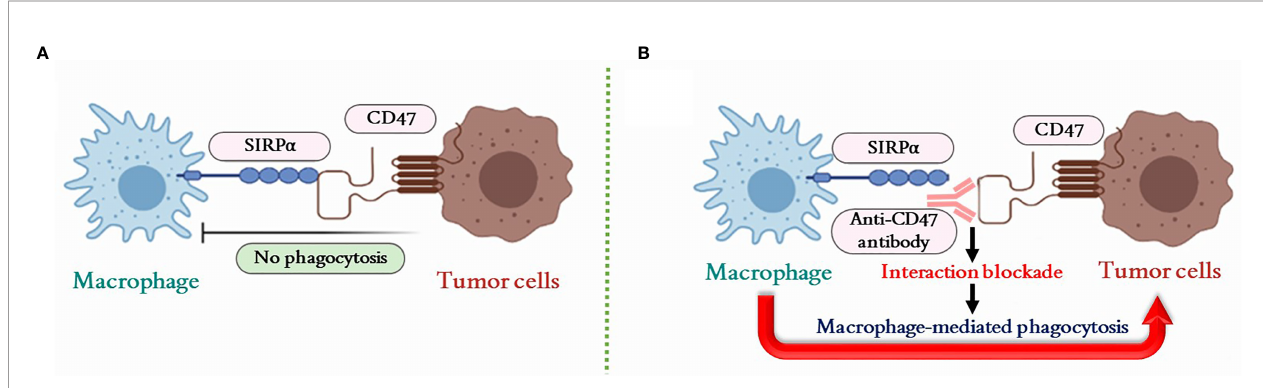
FIGURE 1 | Macrophage-mediated phagocytosis regulated by the CD47 – SIRP a pathway. (A) The CD47 – SIRP a interaction inhibits macrophage-mediated phagocytosis on tumor cells. (B) The interaction of CD47 – SIRP a can be blocked by the anti-CD47 antibody to restore the macrophage-mediated phagocytosis against tumor cells. SIRP a , signal-regulatory protein alpha; CD47, cluster of differentiation